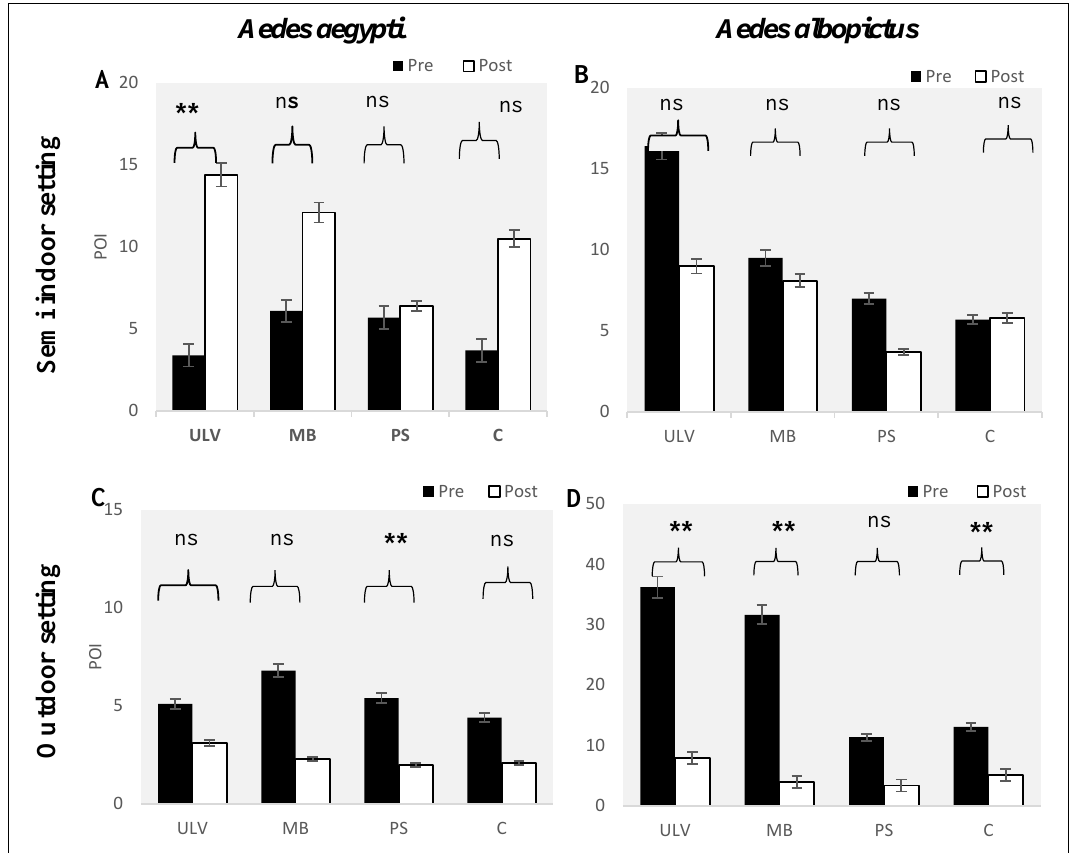
Figure 2. Distribution of pre- and post-treatment based on the positive ovitrap index (POI) of dengue vectors ( A & C : Aedes aegypti ; B & D : Aedes albopictus ) in di ff erent environment settings. Note: